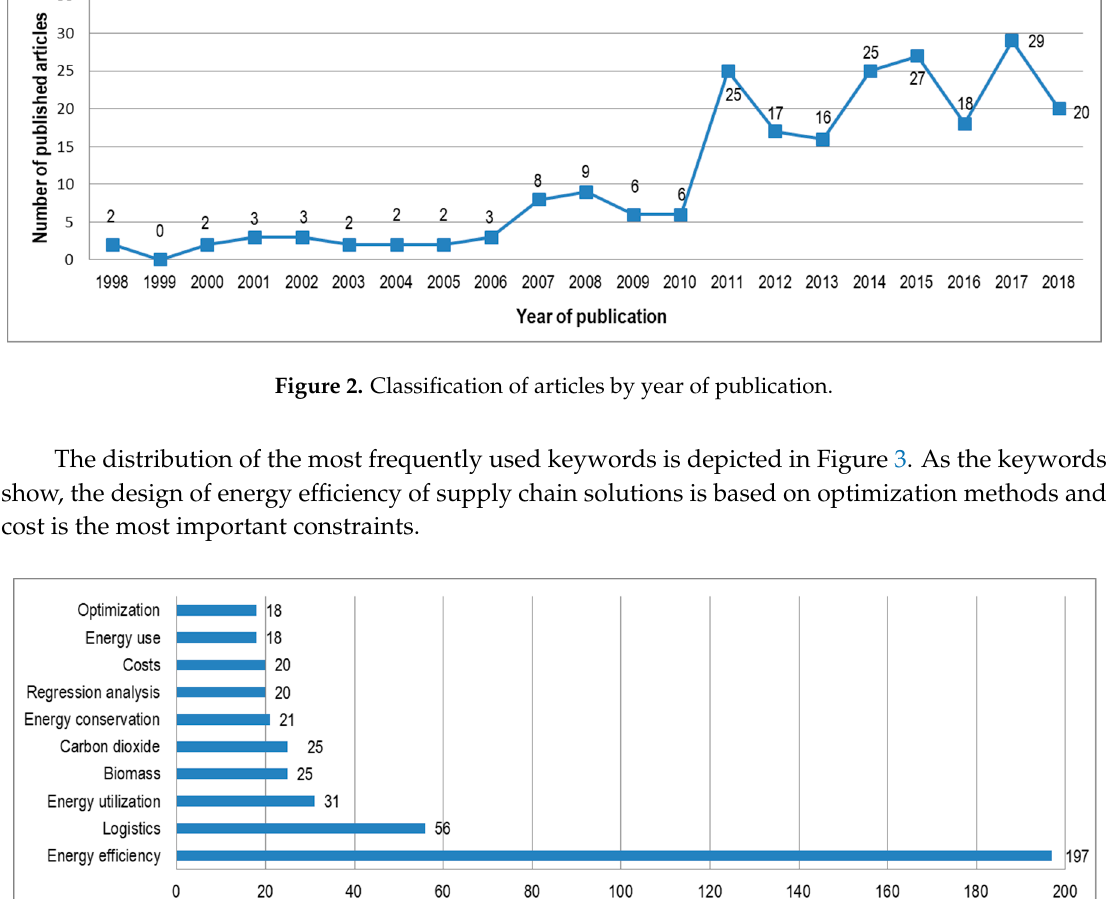
Figure 3. Classification of articles considering the used keywords.